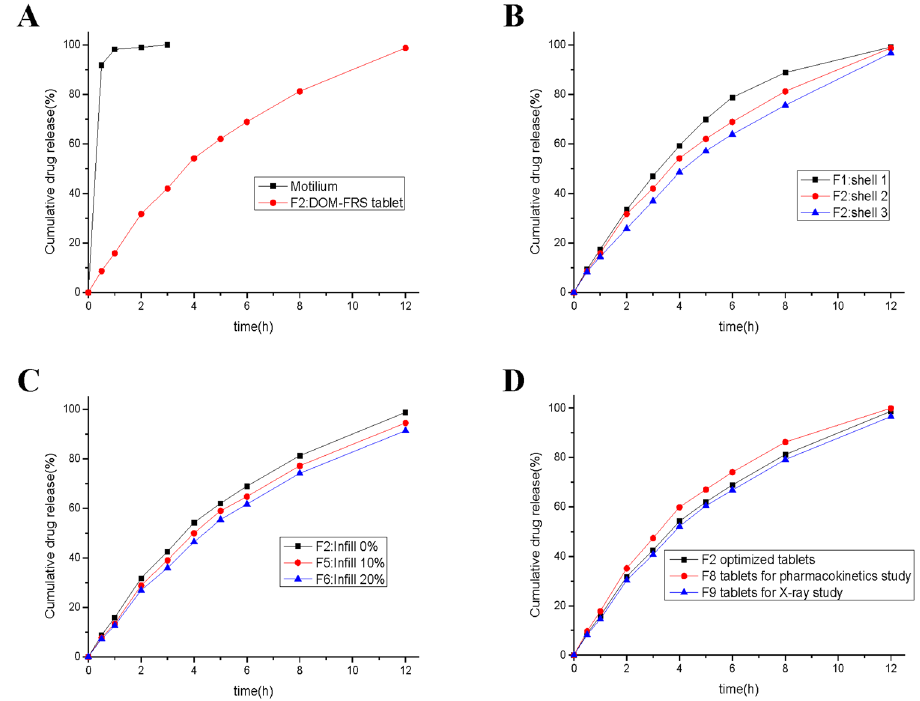
Figure 3. Drug release profiles of the formulations used in the experiments (n = 6): ( A ) comparison of commercial fast-release tablets and DOM-FSR tablets, ( B ) the influence of shell numbers, ( C ) the influence of infill percentages, and ( D ) comparison of the tablets with optimized parameters, tablets used for pharmacokinetic study, and tablets used for X-ray